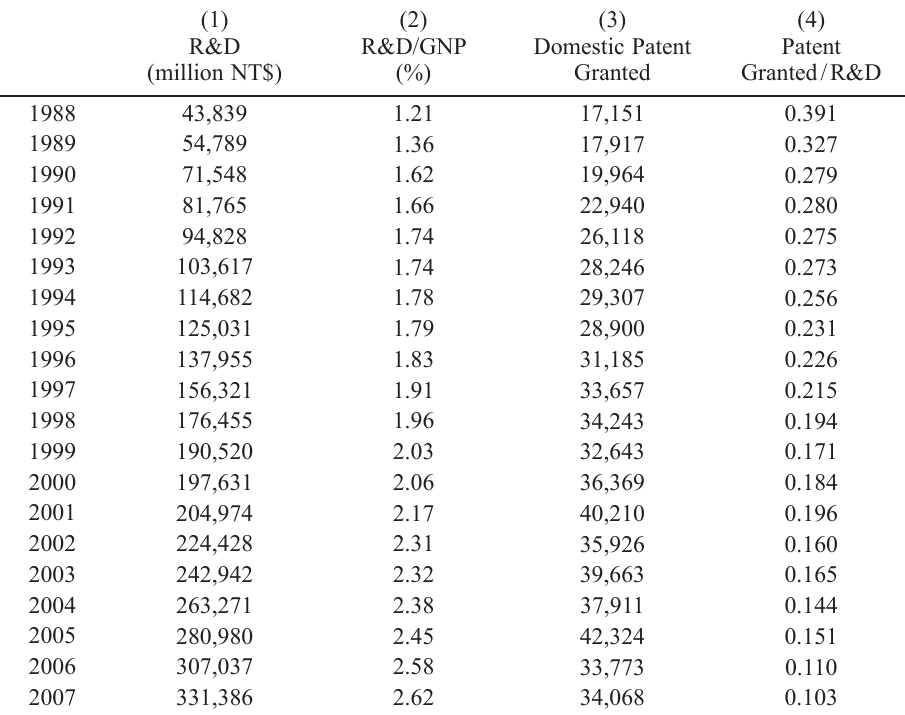
Source: Indicators of Science and Technology of Taiwan, various issues. The process of issuing patents changed in